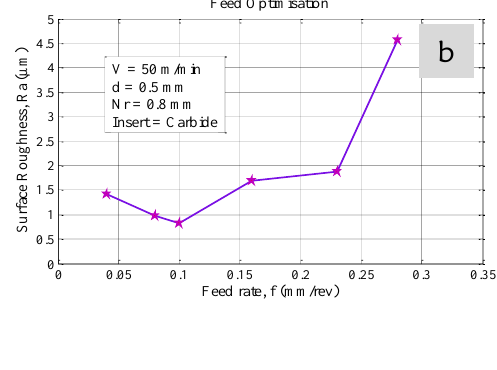
Figure 6: The trend of average surface roughness (Ra)